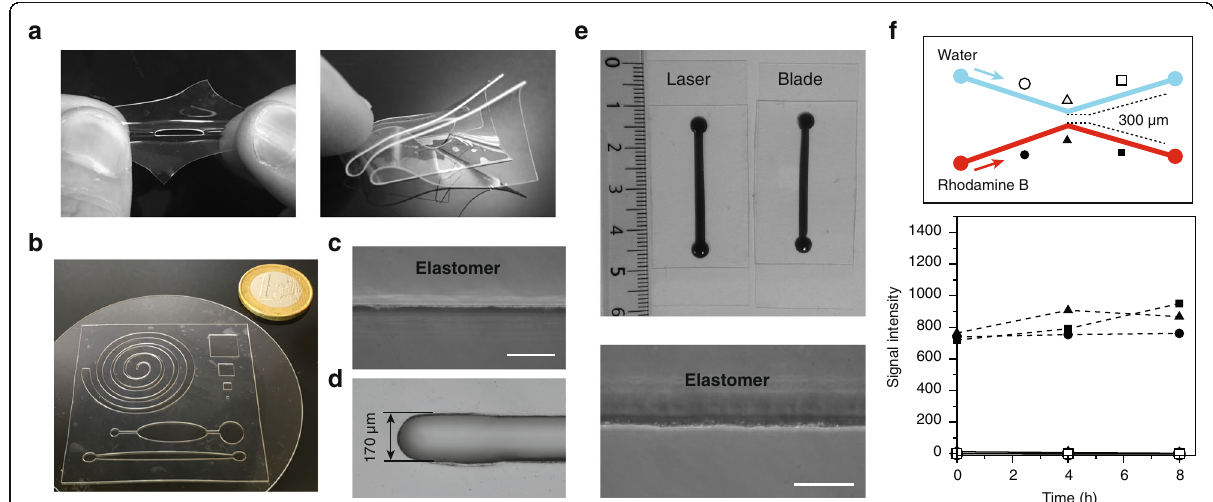
Fig. 1 Fabrication of re-usable microfluidic chips using the LSR elastomer. a. The LSR elastomer is easy-to-manipulate, resistant to both stretching (left panel) and folding (right panel). b. Complex patterns can be fabricated using a CO 2 laser cutter. A schematic of these patterns is presented in Additional file 4A. c. Microscopy image of a laser-cut elastomer sheet showing the precision of the cutting procedure along the edge of the cut. Bright-field image (20×). Scale bar = 100 μ m. d. The narrowest channel that can be obtained with a 50 μ m beam CO 2 laser cutter is ~ 170 μ m wide. A piece of elastomer was placed between 2 liners taken from double-sided adhesive prior to cutting. Bright-field image (10×). Scale bar = 100 μ m. e. Microchannels can be generated in elastomer sheets using a razor blade and biopsy puncher. Top panel: comparison of similar channels fabricated using a laser (left) and a razor blade (right). A dye is used for ease of visualization. Bottom panel: the use of a razor blade allows for high quality cuts. Bright-field image (20×). Scale bar = 100 μ m. f. Multichannel microfluidic chips. An elastomer chip comprising 2 channels (500 μ m wide) separated by 300 μ m at the middle section (left panel) was fabricated and intercalated between two glass coverslips. The two channels were injected with either water or Rhodamine B (5 μ M) at a constant flow of 20 μ l/min, and the fluorescence intensity at the indicated positions (geometric marks) was measured over time (right panel). T = 0 corresponds to 5 min after the start of the perfusion. Data were corrected for the background measured at the entrance of the water channel at T =